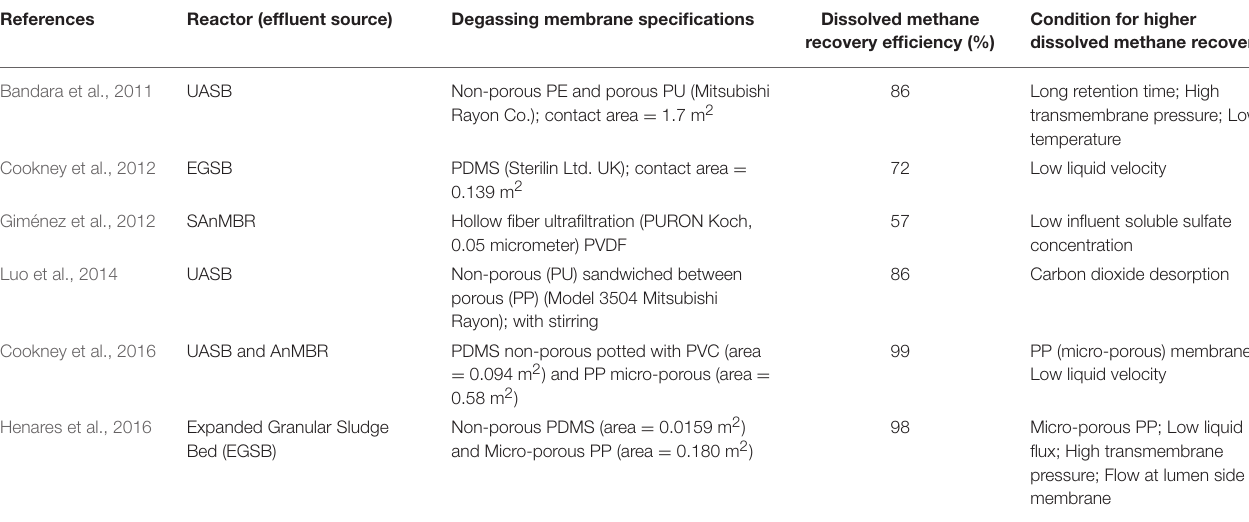
TABLE 1 | Literature on degassing membrane for improved dissolved methane